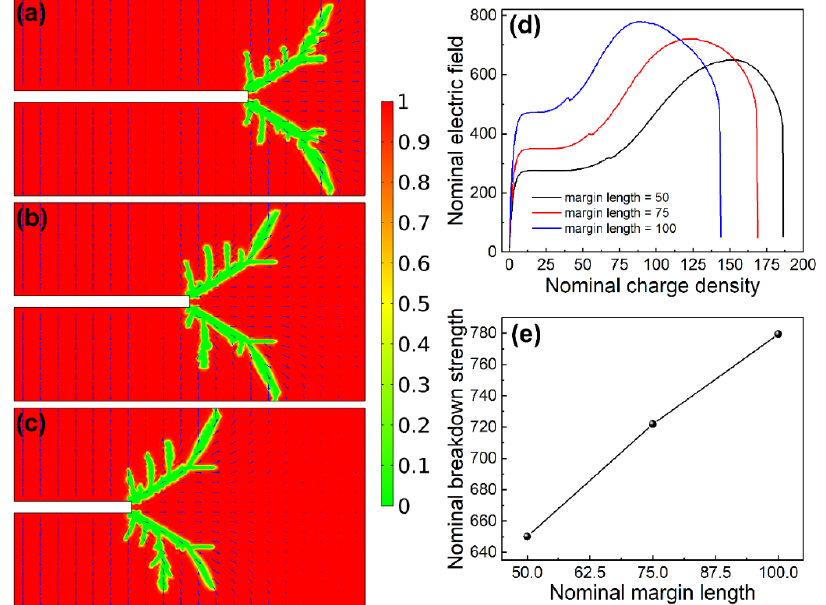
Fig. 24 Final patterns of the breakdown path for the selected region of MLCCs with various nominal margin lengths of (a) 50, (b) 75, and (c) 100. The shading represents the damage variable s and the arrows indicate the polarization vectors P . (d) Nominal field–charge–density relation of MLCCs with various margin lengths. (e) Nominal breakdown strength as a function of the MLCC margin length. Reproduced with permission from Ref. [121], © Author(s)